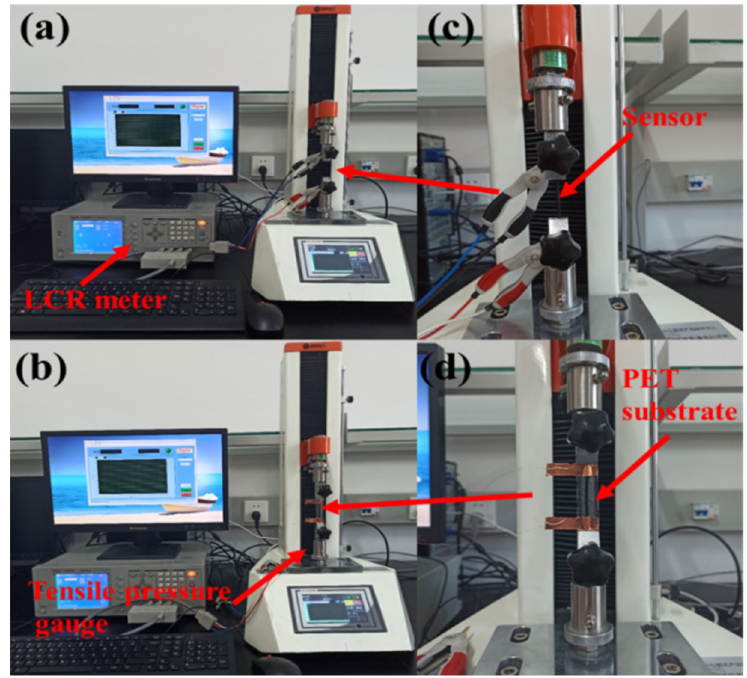
Figure 3. Experimental setup for sensor testing: ( a ) tensile properties testing process diagram; ( b ) bending properties testing process diagram; ( c ) a partially enlarged view of ( a ); ( d ) a partially enlarged view of ( b ).